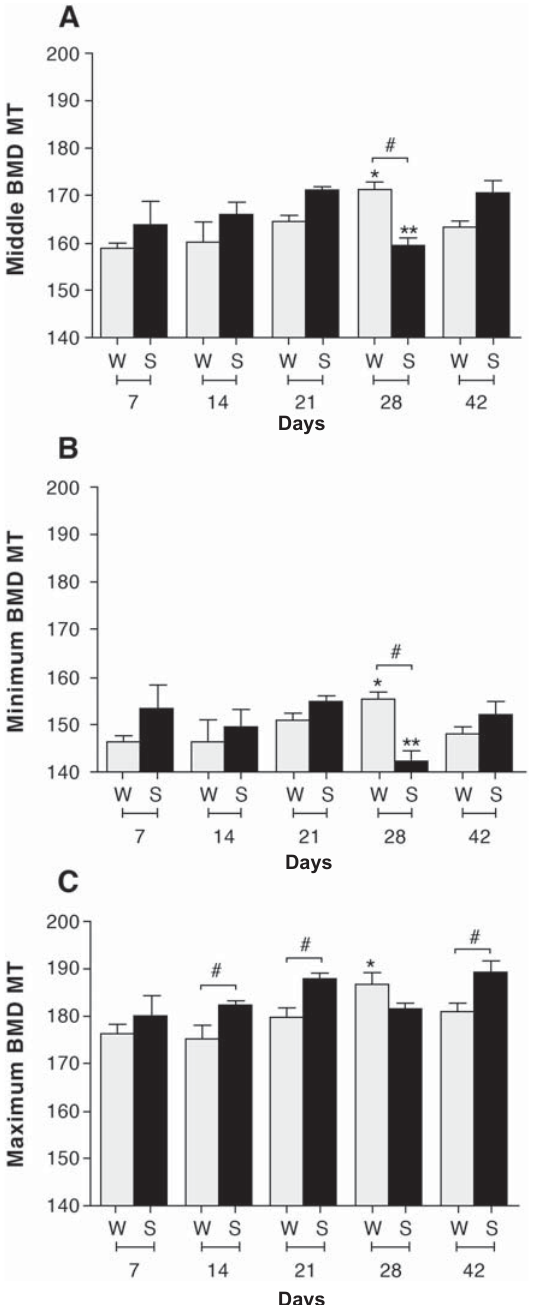
Figure 3- Bone mineral density (BMD) in the apical third (AT) of the alveolus. A) Middle BMD, B) Minimum BMD, (cid:2)(cid:3)(cid:4)(cid:5)(cid:6)(cid:7)(cid:8)(cid:9)(cid:10)(cid:9)(cid:4)(cid:11)(cid:5)(cid:12)(cid:13)(cid:4)(cid:14)(cid:12)(cid:8)(cid:15)(cid:15)(cid:16)(cid:17)(cid:16)(cid:18)(cid:19)(cid:16)(cid:4)(cid:6)(cid:9)(cid:20)(cid:18)(cid:21)(cid:4)(cid:22)(cid:20)(cid:23)(cid:24)(cid:20)(cid:22)(cid:16)(cid:17)(cid:6)(cid:24)(cid:8)(cid:25)(cid:16)(cid:4)(cid:30)(cid:6)(cid:31)(cid:23)(cid:4) of Wistar rats (Medium and minimum BMD: 28x7